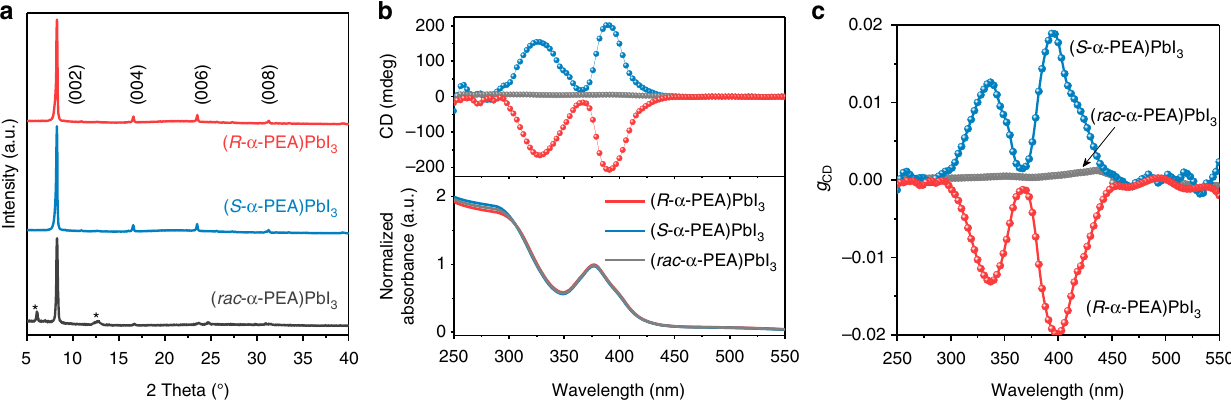
Fig. 2 The characterization of ( α -PEA)PbI 3 fi lms. a XRD patterns of ( R -, S -, and rac - α -PEA)PbI 3 fi lms. The peaks marked with stars can be assigned to the (002) and (004) peaks of ( α -PEA) 2 PbI 4 phase. b CD and absorbance spectra of highly-oriented ( R -, S -, and rac - α -PEA)PbI 3 fi lms. c The g CD spectra of ( R